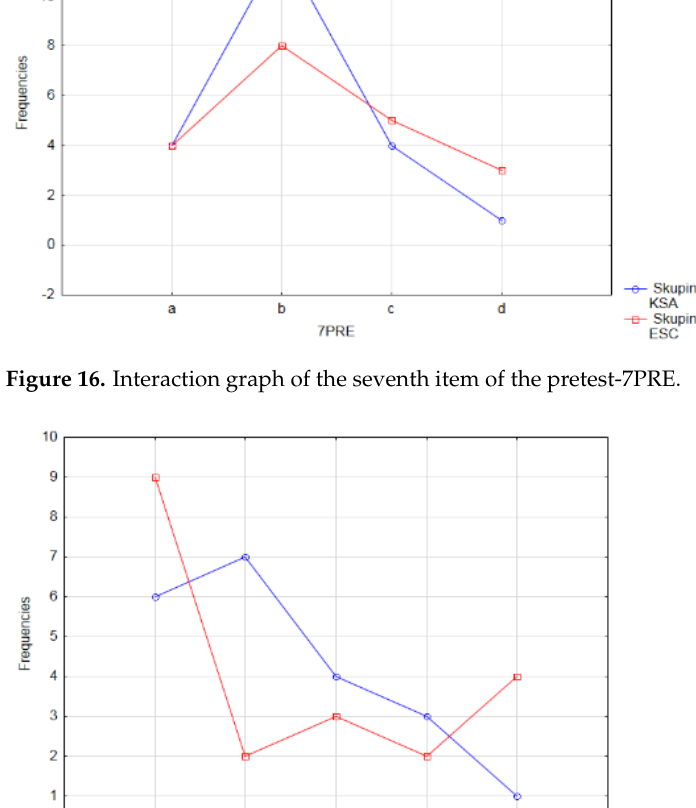
Figure 18. Interaction graph of the sixth item of the posttest - 6POST. Figure 19. Interaction graph of the seventh item of the posttest - 7POST.